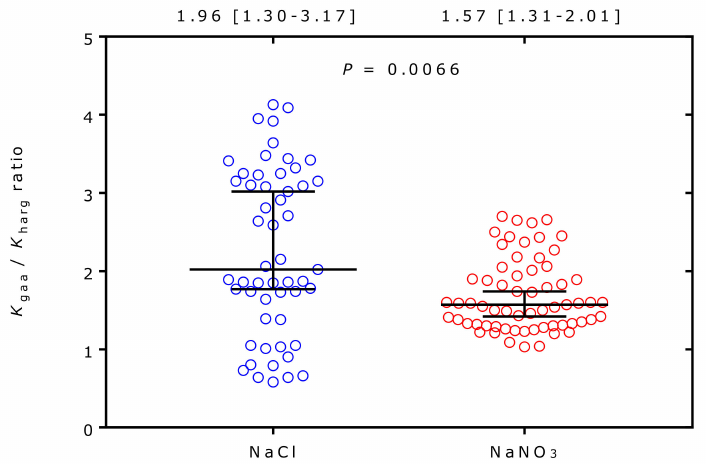
Figure 2. K gaa / K harg ratios in the NaCl group ( n = 53) compared to the NaNO 3 group ( n = 63) on day 9 after supplementation. The values determined at all exercise timepoints in each group were considered and presented as the median with 95% confidence